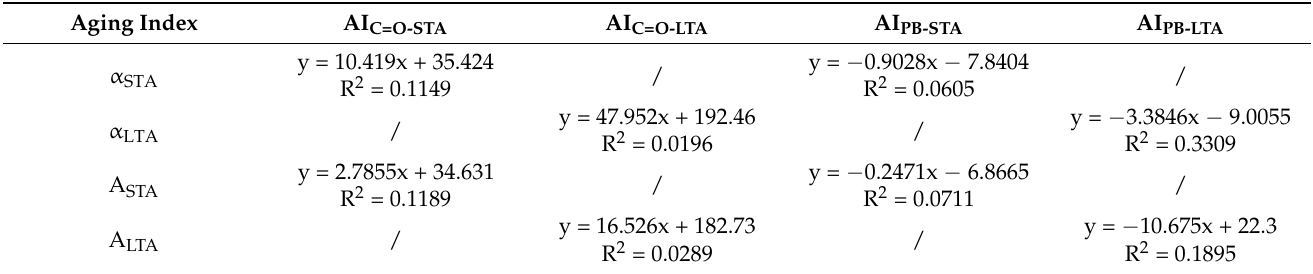
Table 13. Relationship between the FTIR aging index and the rheological aging